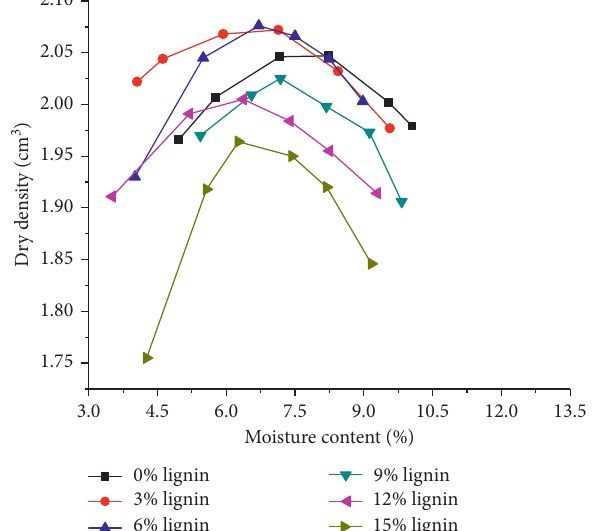
Figure 2: The results of the compaction test.